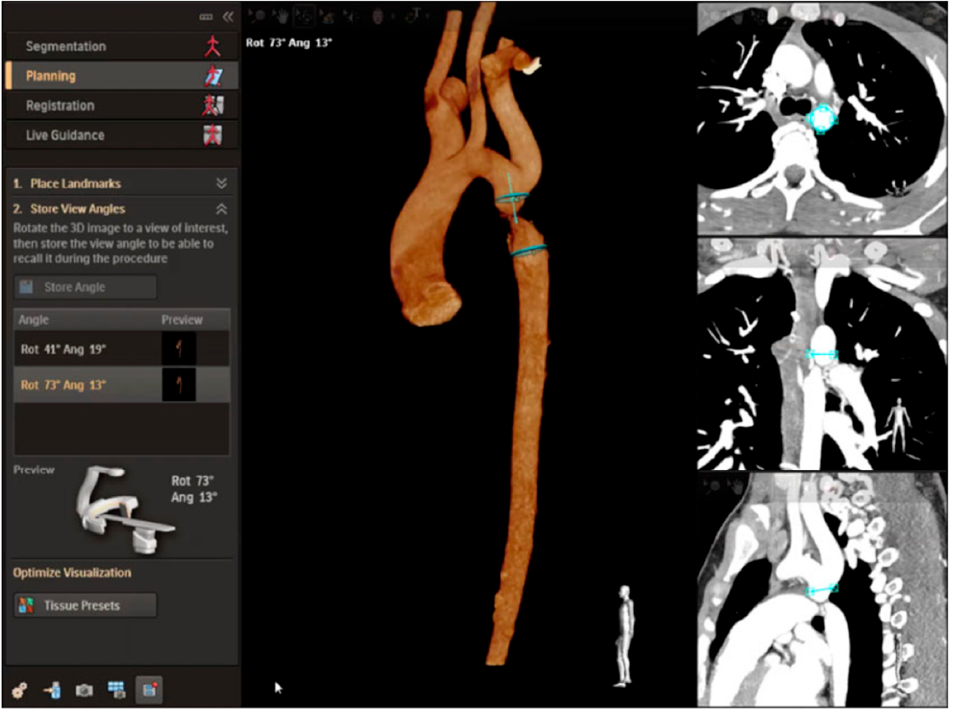
Figure 14. Overlay planning using the VesselNavigator system (Philips Healthcare, Best, NL) for a patient with a discrete coarctation of the aorta (CoA) prior to stenting using CT images. The area of interest is outlined in blue. Revised from ref [9].